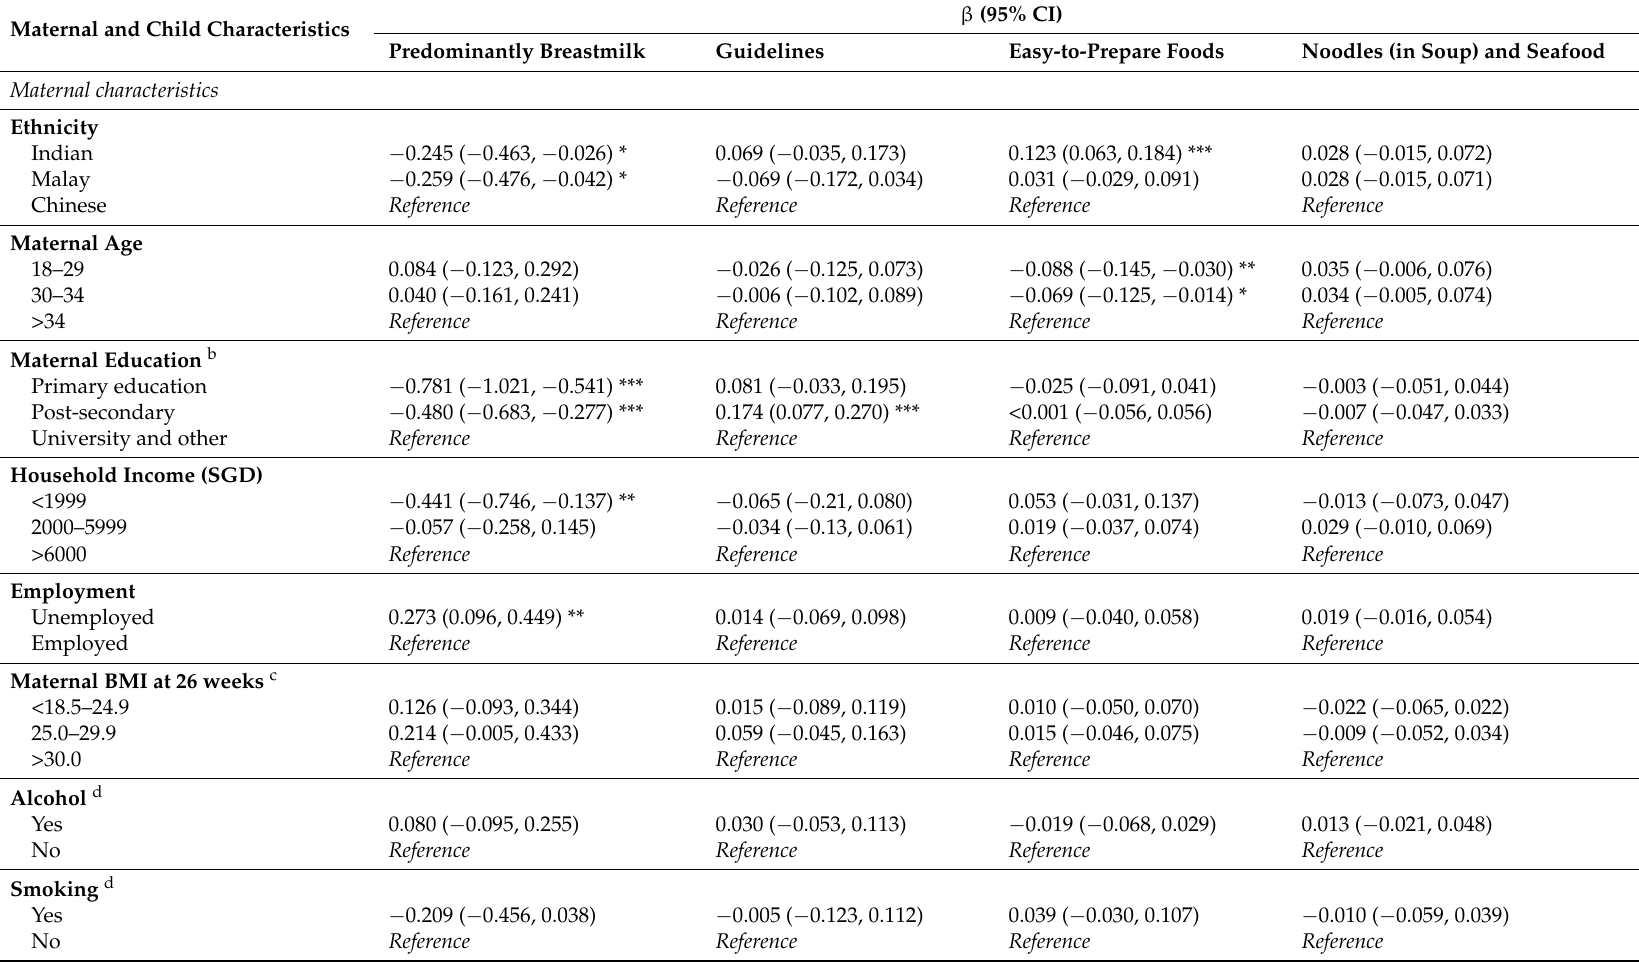
Table 1. Adjusted associations between dietary pattern trajectory intercepts and sociodemographic characteristics ( n = 486) a